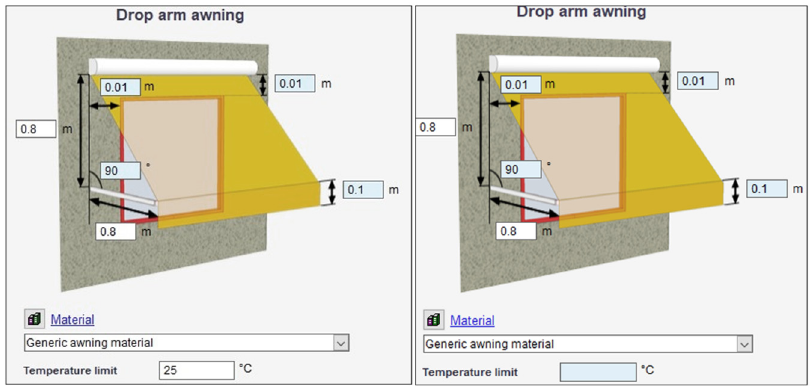
Figure 7. Used ESs; temperature-controlled on the left and sun-controlled on the right.